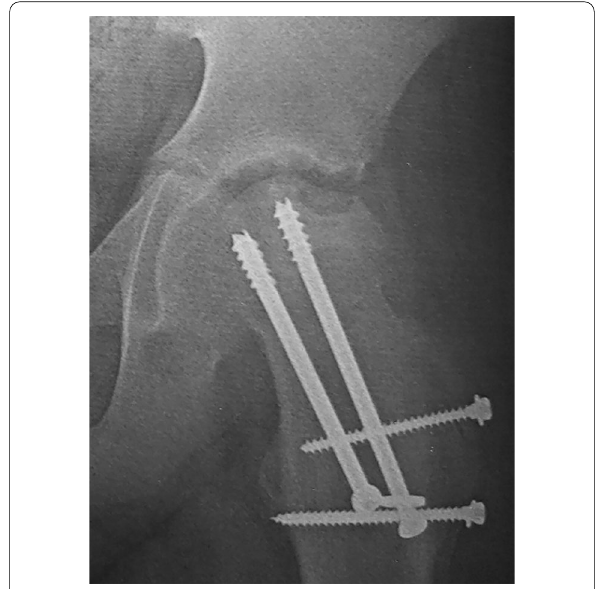
Fig. 8 Plain X‑ray (AP view) showing segmental avascular necrosis of the femoral